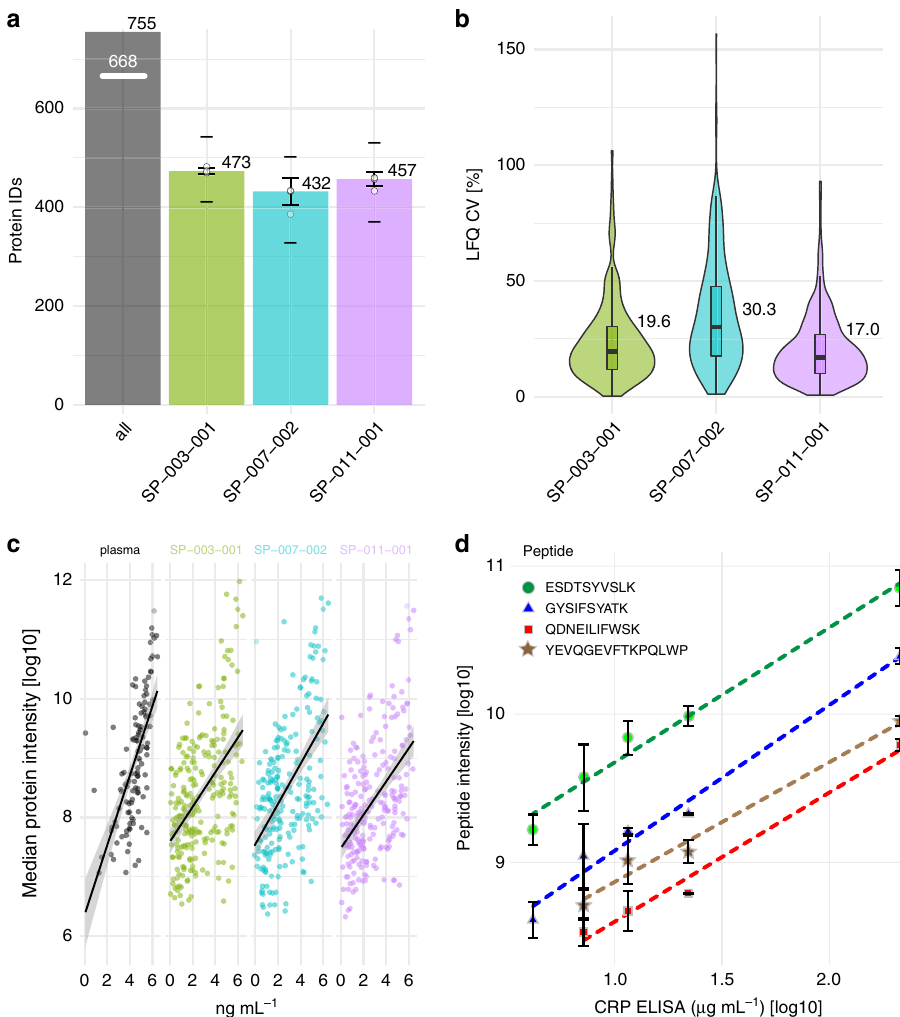
Fig. 3 Proteomics characterization of the three initial SPIONs. a Protein groups from the NP corona of the three initial SPIONs, SP-003, SP-007, and SP- 011 as determined by DDA LC-MSMS and MaxQuant (MaxLFQ, 1% protein and peptide FDR). All: represents proteins detected across all NPs. White line indicates the number of proteins detected with two or more peptides with at least one NP. For respective NPs median count and standard deviation across three assay replicates are shown as bar plots. Upper dashes depict number of proteins detected in any sample; lower dashes depict number of proteins detected in all three replicates. White circles show number of protein IDs for each assay replicate. b CV% for precision evaluation (MaxLFQ, fi ltering for three out of three valid values) of the NP protein corona-based Proteograph work fl ow. Inner boxplots report the 25% (lower hinge), 50%, and 75% quantiles (upper hinge). Whiskers indicate observations equal to or outside hinge ± 1.5 * interquartile range (IQR). Outliers (beyond 1.5 * IQR) are not plotted. Violin plots capture all data points. c Correlation of the maximum intensities of NP corona proteins vs. plasma proteins to the published concentration of the same proteins (median of assay triplicates). The black lines are linear regression models, and the grey shaded regions represent 95% con fi dence interval. d Linearity of response for measurement for CRP protein on the SP-007 NP in a spike-recovery experiment. Error bars denote standard deviations around the mean. All data were acquired in n = 3 independent assay replicates. Source data are provided as a Source Data fi regression model fi tted to 1308 other (nonspiked) MS features identi fi ed in at least four of the fi ve plasma samples, for which signals from associated MS features should not vary across samples, had a slope of − 0.086 (95% CI − 0.1 to − 0.068). These results indicate that the NPs ’ linearity of response will likely prove useful in quantifying potential markers in comparative studies.